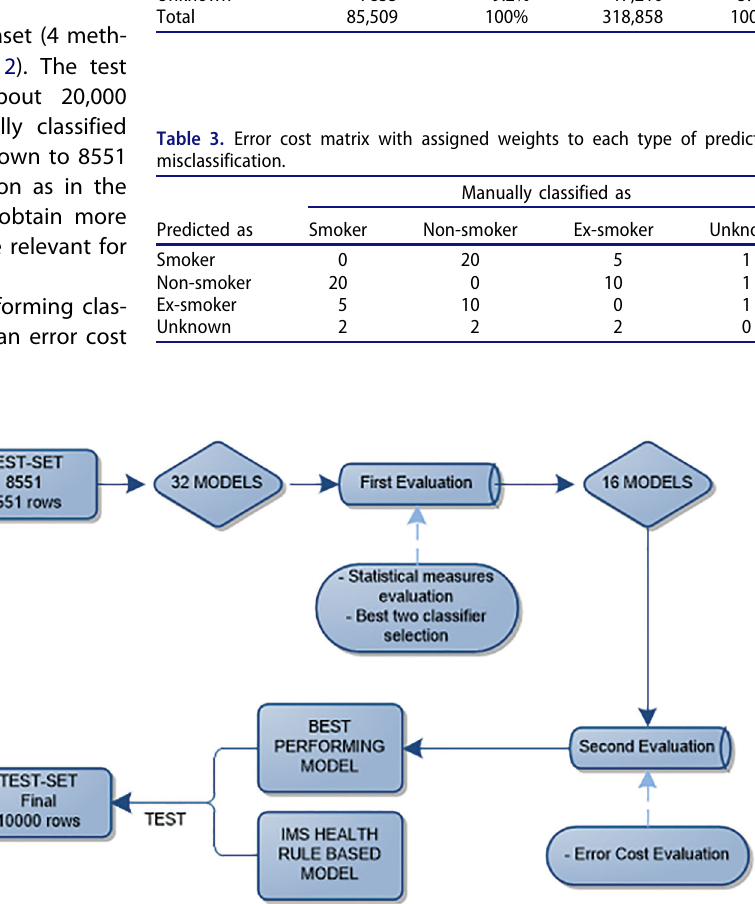
Figure 2. Evaluation workflow.